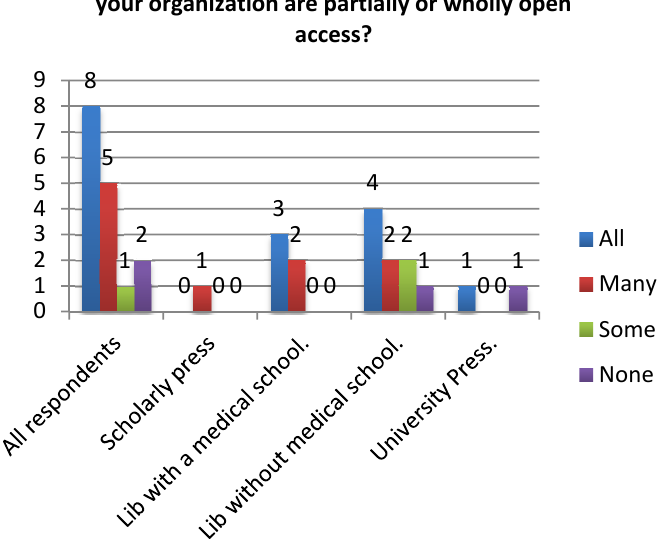
Figure 1. Proportion of journals hosted that are Open Access